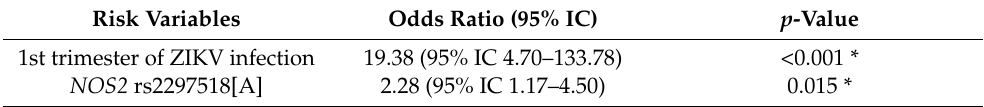
Table 4. Univariate logistic regression showing risk variables for the Congenital Zika